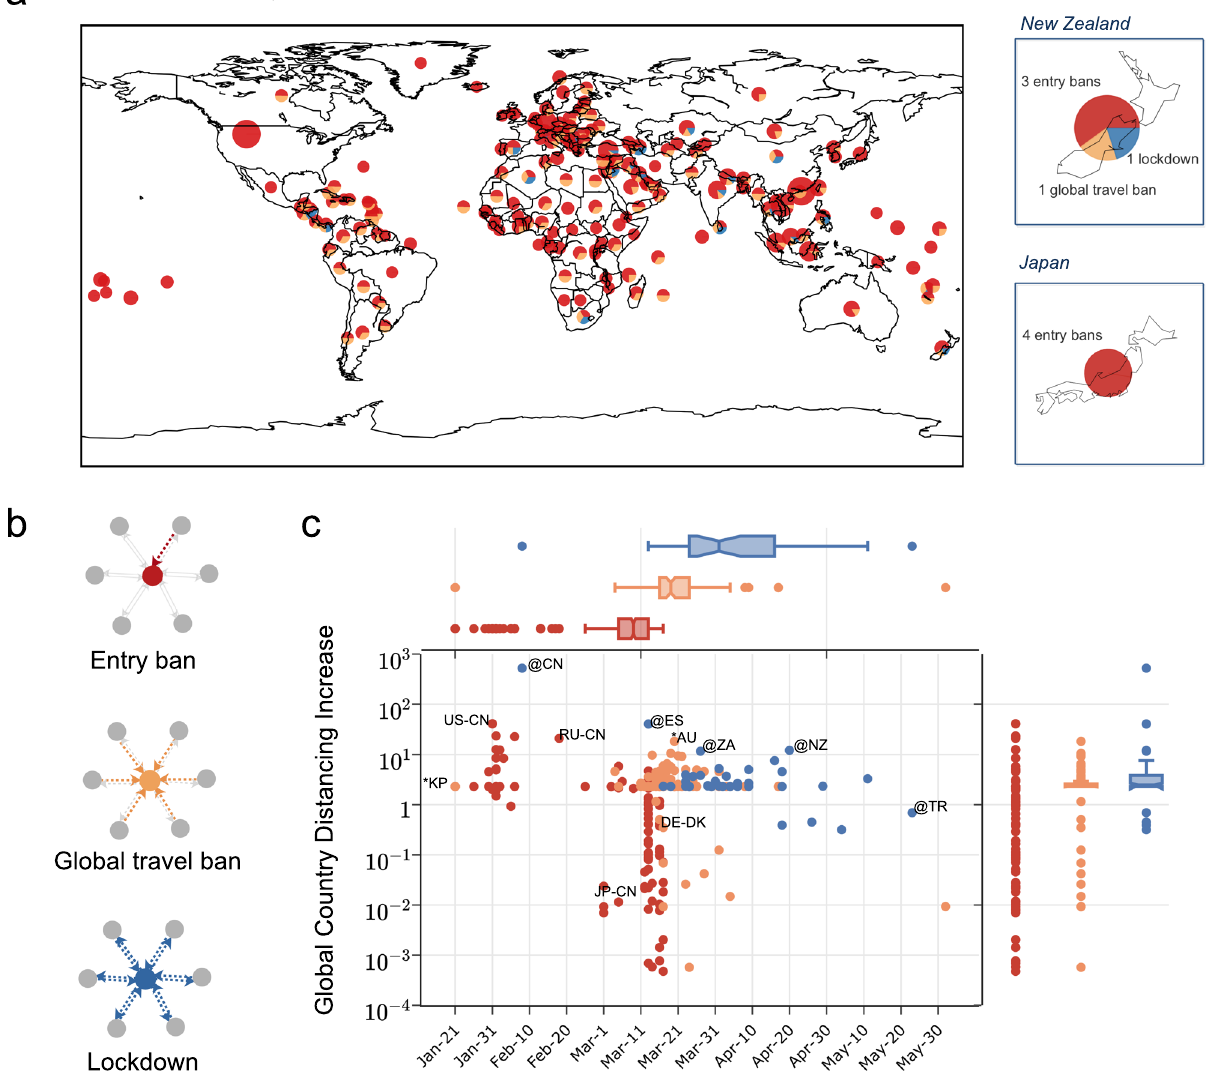
Fig. 3 Illustration of existing travel restrictions (i.e., entry bans, global travel bans, and lockdowns) until 1 June 2020. a shows geographic areas ’ implemented travel restrictions. Each pie in the global map represents the share of entry bans (in red), global travel ban (in orange), and lockdown (in blue) that the area imposed. For example, New Zealand imposed three entry bans, one global travel ban, and one lockdown, whereas Japan imposed four entry bans. b illustrates how the entry ban, global travel ban, and lockdown reduce airline passenger in fl ux. When the colored areas (in red, orange, and blue) enforce the entry ban, the global travel ban, or the lockdown, the passenger in fl ux on corresponding colored links is reduced (dotted links). The outward/ inward arrows indicate restricting travelers exiting/entering. c shows the implementation time of existing travel restrictions versus their induced global country distancing increase. Each dot represents the travel restriction. Among the marks, for example, “ US-CN ” represents the entry ban ( “ - ” ) imposed by the United States (US) on mainland China (CN); “ *KP ” represents the global travel ban ( “ * ” ) imposed by North Korea (KP); and “ @CN ” represents the lockdown ( “ @ ” ) imposed by mainland China (CN). For clear visualization, geographical areas are presented by two-letter codes. Please see Supplementary Table 5 for geographical areas ’ two-letter codes. The marginal charts of c show the standardized box plots of travel restrictions ’ implementation time and country distancing increase on the top and right,